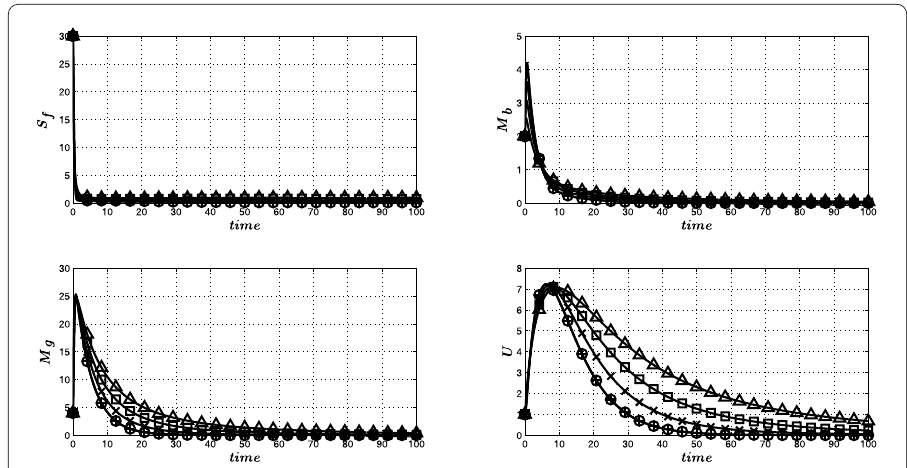
Figure 2 Simulation curves of S f , M b , M g and U for different values of α . α = 0.85 ( (cid:10) ), α = 0.9 ( (cid:2) ), α = 0.95 ( × ), α = 1 ( (cid:11) ) and classic integer